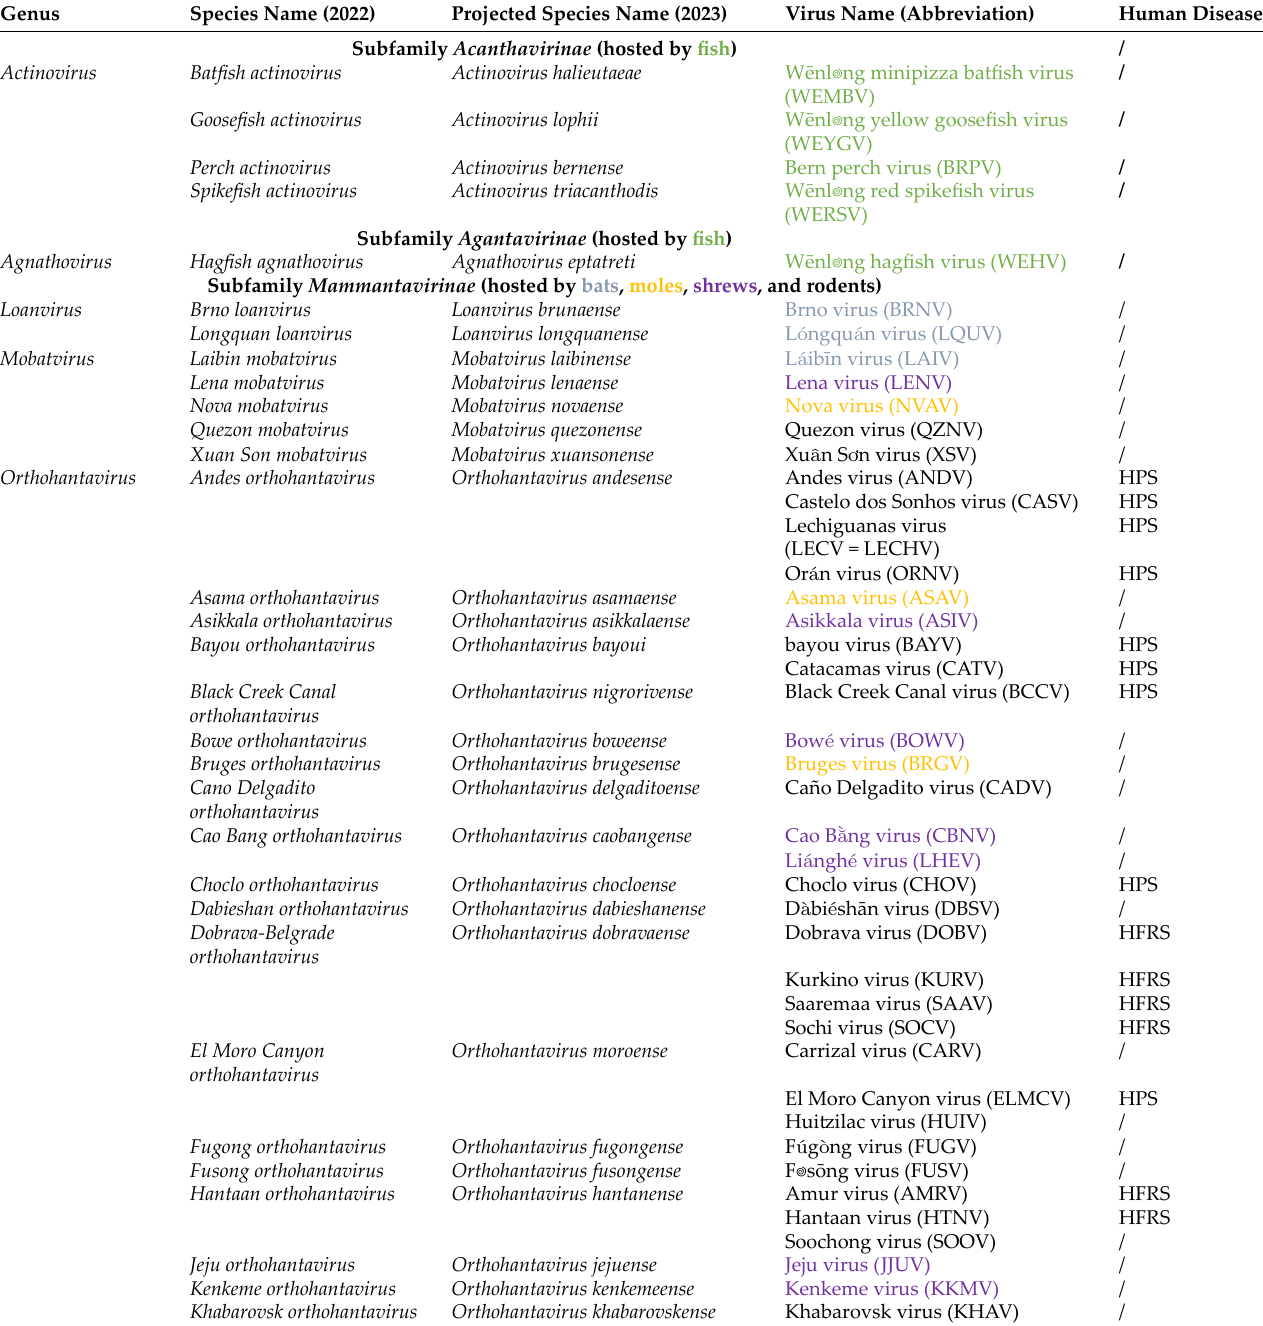
Table 1. 2022 [83] and projected 2023 [84] taxonomies of the bunyaviral family Hantaviridae